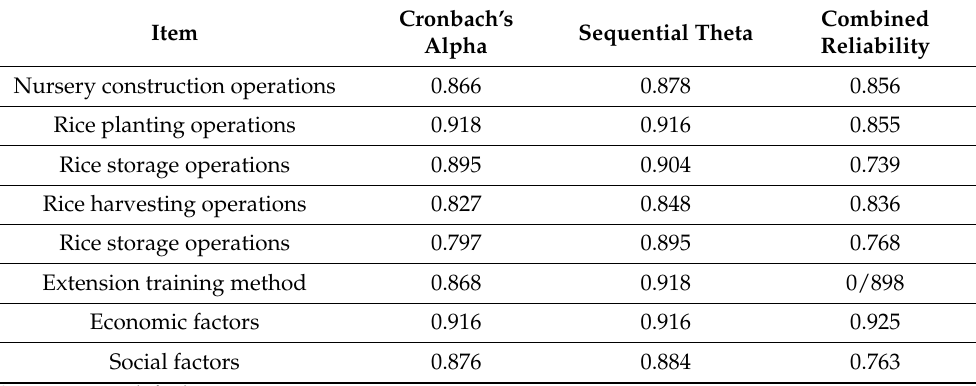
Table 1. Results from Cronbach’s alpha, sequential theta, and combined